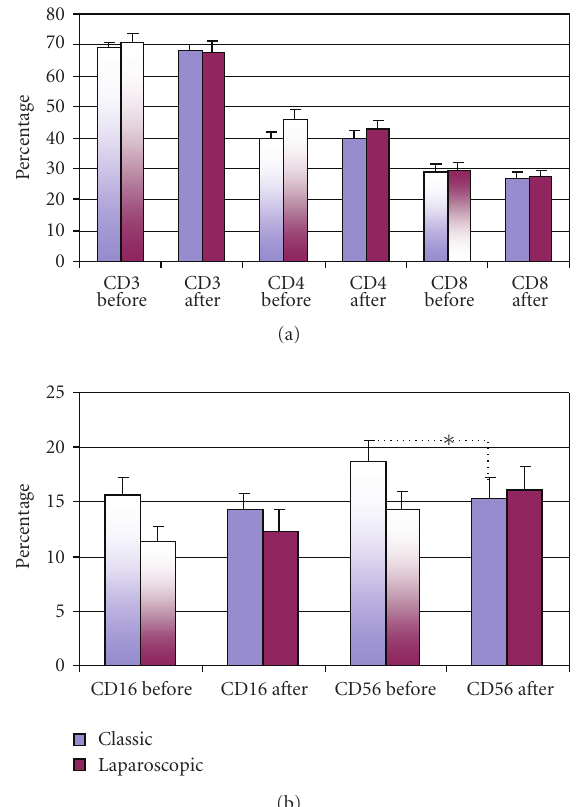
Figure 2: Percentage of surface marker positive T lymphocytes (a) and NK cells (b) (mean percentage ± S.E.M.) in peripheral blood from patients subjected to classic or laparoscopic cholecystectomy before (two-colored columns) and after operation (one-colored column). ∗ Statistical significance between the preoperative and postoperative values ∗ P < .